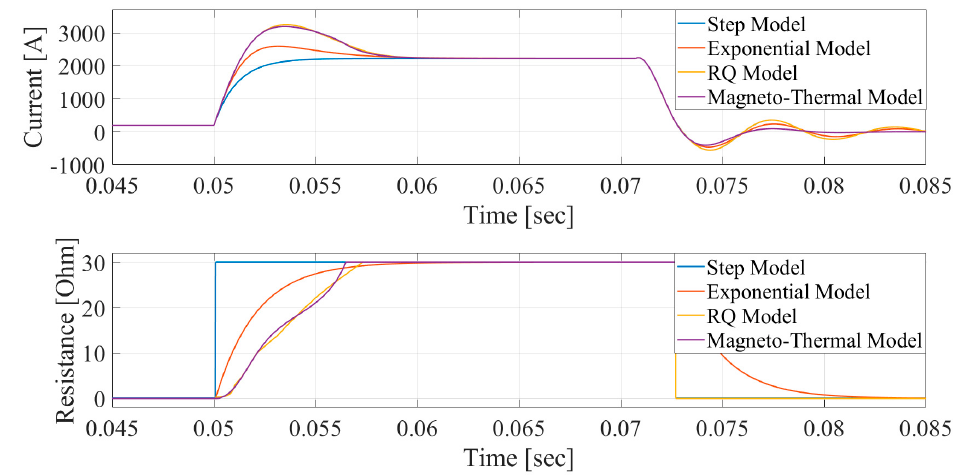
Figure 12. Model comparison for 300 A critical current and 5 Ω fault resistance.